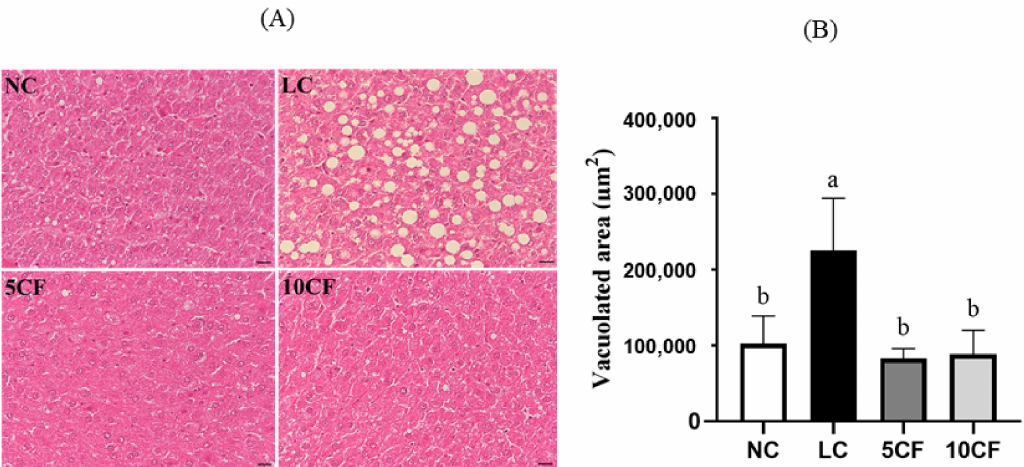
Figure 6. The hepatic morphological change in rats fed with different experimental diets for 11 weeks. Representative hematoxylin and eosin (HE)-stained images of fat vacuoles in liver tissues are shown ( A ) and quantified ( B ). Results are expressed as the mean ± SD for each group ( n = 8). Mean values with different letters are significantly different, p <